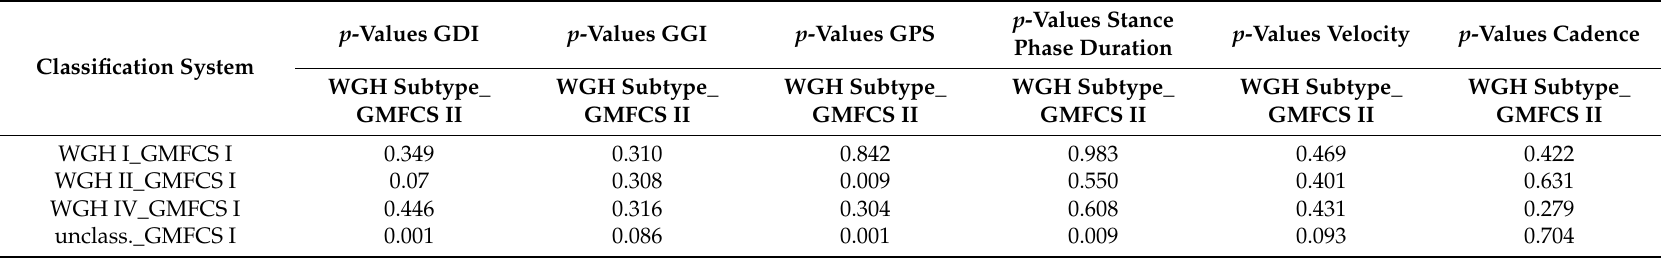
Table 4. Comparative statistics between GMFCS levels for each WGH subtype. Each WGH subtype was further subgrouped according to GMFCS. Comparisons (using t -test) were done for all gait indices and all spatiotemporal parameters for WGH I_GMFCS I vs. WGH I_GMFCS II